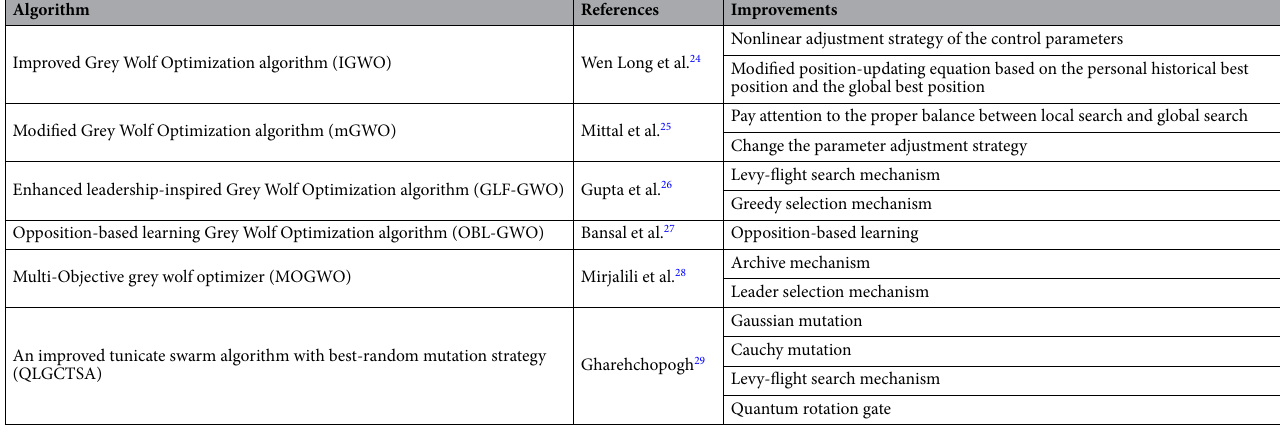
Table 1. A summary of popular